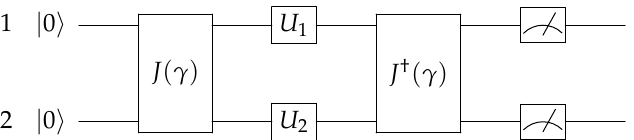
Figure 2. A depiction of the the circuit model of the quantum prisoner’s dilemma as proposed by Eisert et al. in